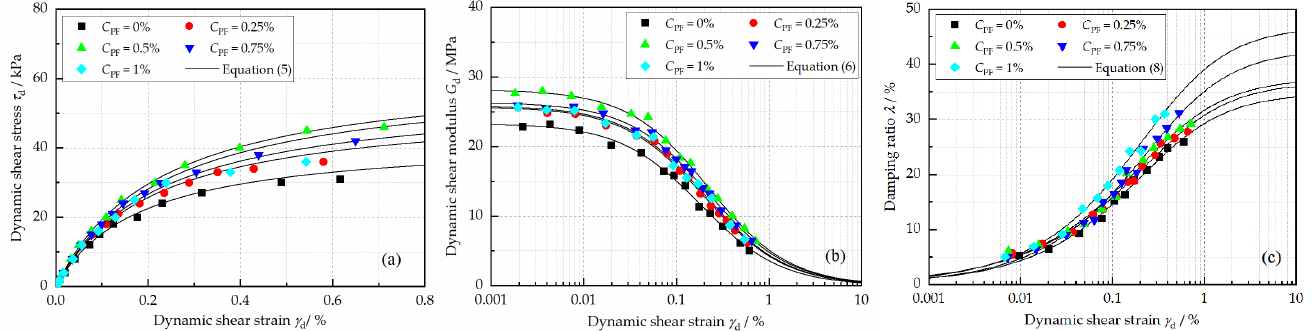
Figure 7. Effects of polypropylene fiber content on ( a ) backbone curve, ( b ) dynamic shear modulus, and ( c ) damping ratio under the conditions of N = 5, C FA = 20%, w = 18.9%, and σ 3 = 100 kPa.